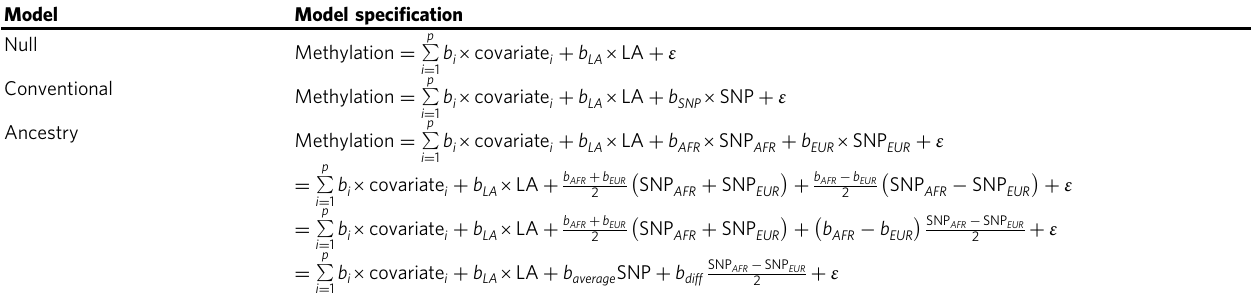
Table 3 Methylation quantitative trait loci (meQTL) model speci fi cations for the null, conventional, and ancestry models.